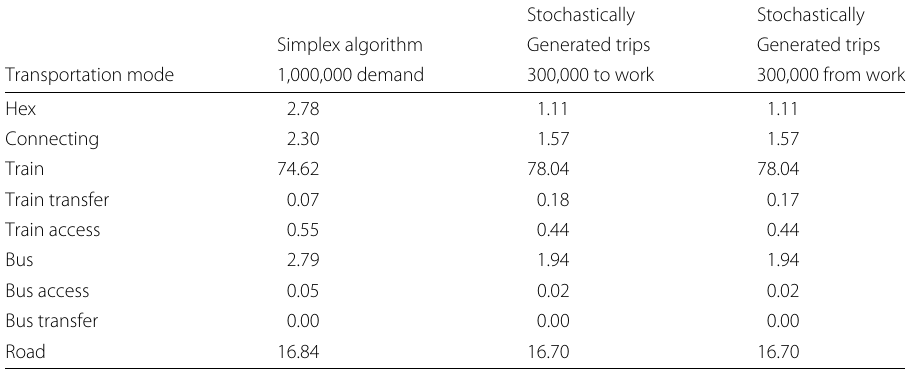
Table 5 Percent of the total distance comprised of by links of each modality for our three generated flow